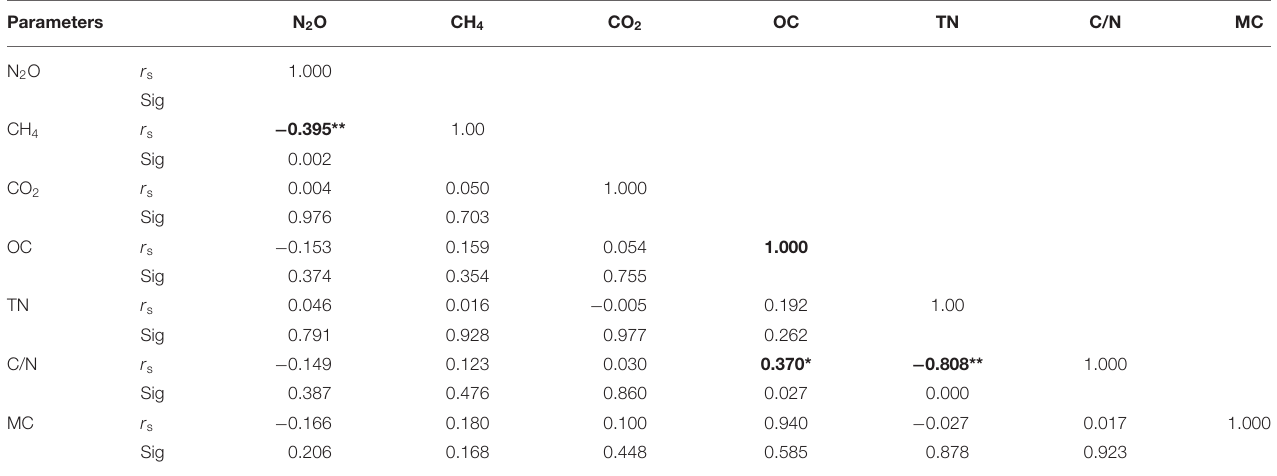
TABLE 2 | Correlation matrix between GHGs, organic carbon, total nitrogen and carbon-nitrogen ratio. Parameters N 2